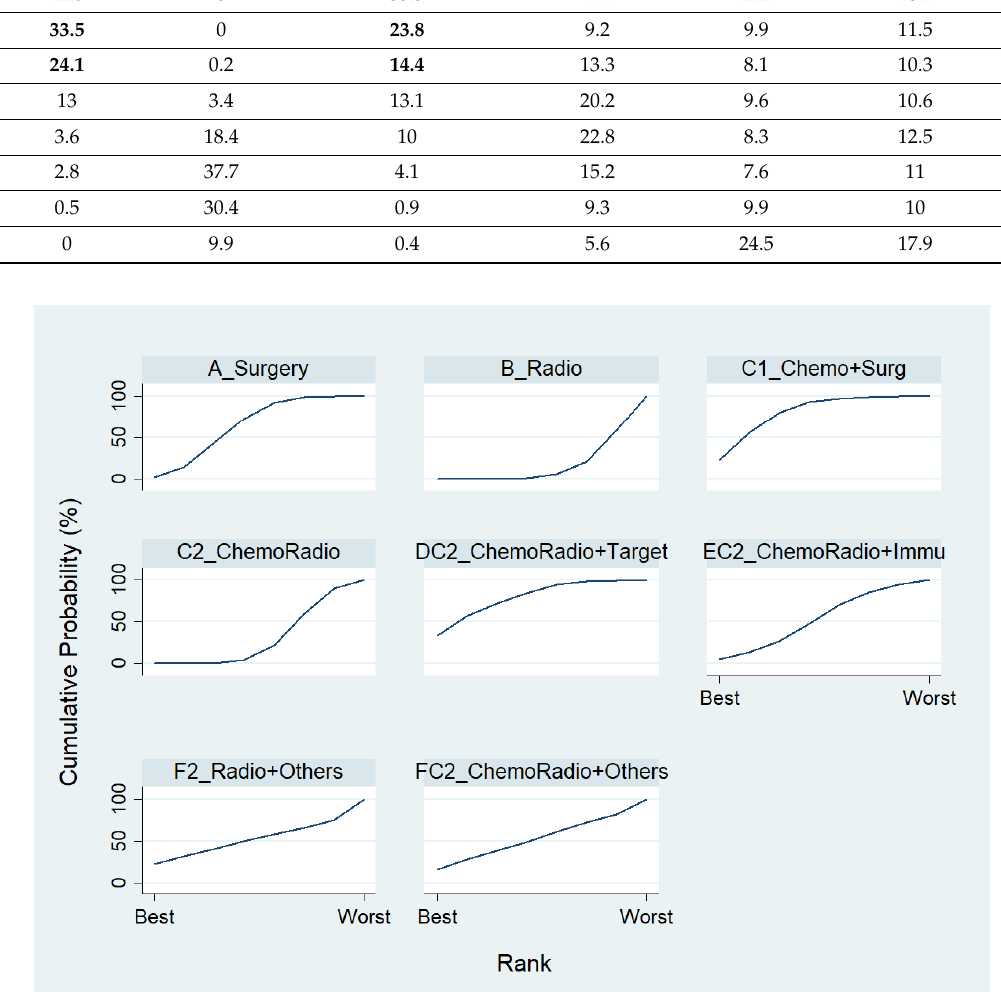
Figure 8. Rankogram for the non-advanced lung cancer in disease-free control rate.